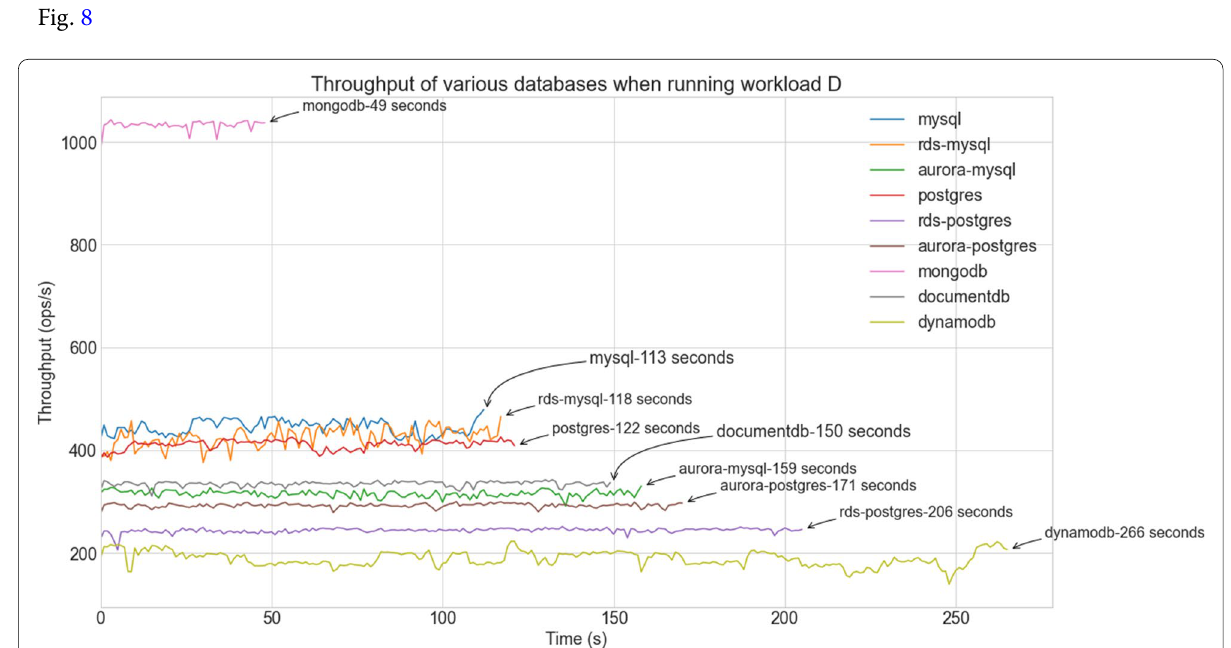
Fig. 8 Performance of databases with Workload‑d (equal number of inserts and